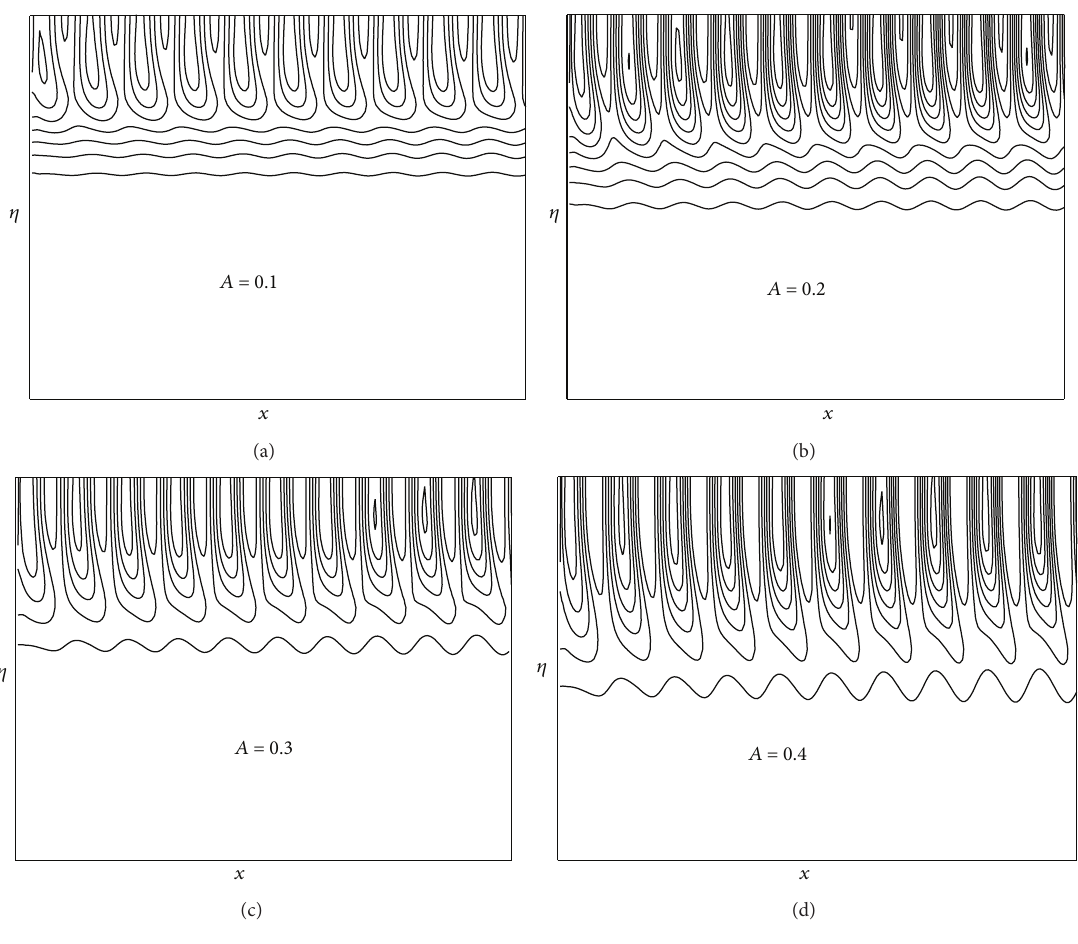
Figure 9: Le = 1 , Pr = 1 , 𝐴 = 0.1 , Nr = 0.1 , Nt = 0.1 , and Nb = 0.5